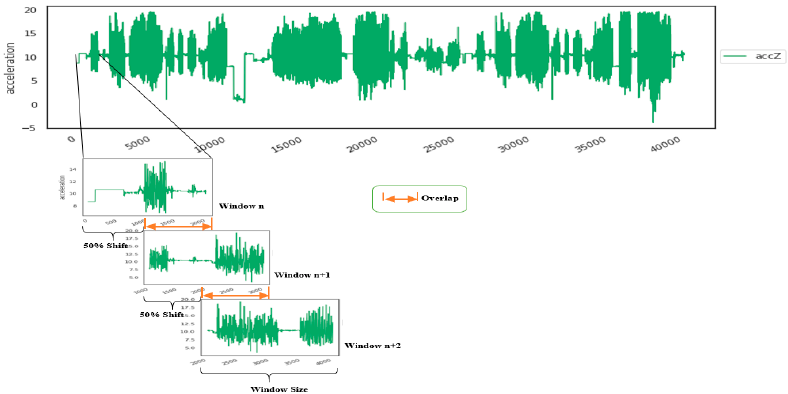
Figure 4. Sliding window with 50%